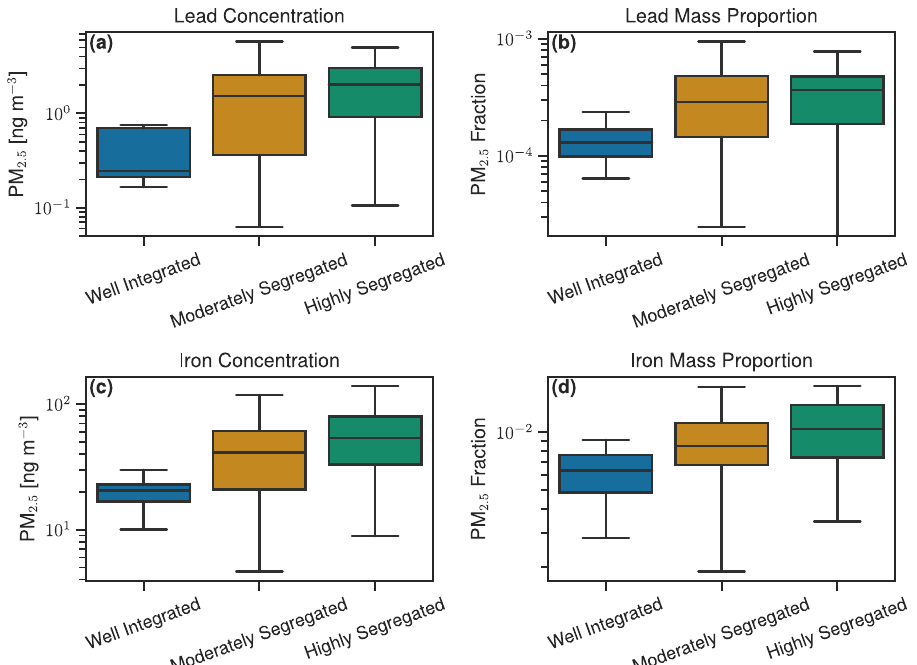
Fig. 2 | Exposure distributions for fi ne particulate metals across RRS cate- gories. The top row depicts lead PM 2.5 a concentrations and b mass proportions (representing anthropogenically dominated-emitted particulate metals). The bot- tomrowdepictsironPM 2.5 ( c) concentrationand d massproportions(representing naturally dominated-emitted particulate metals). RRS categories include: well-